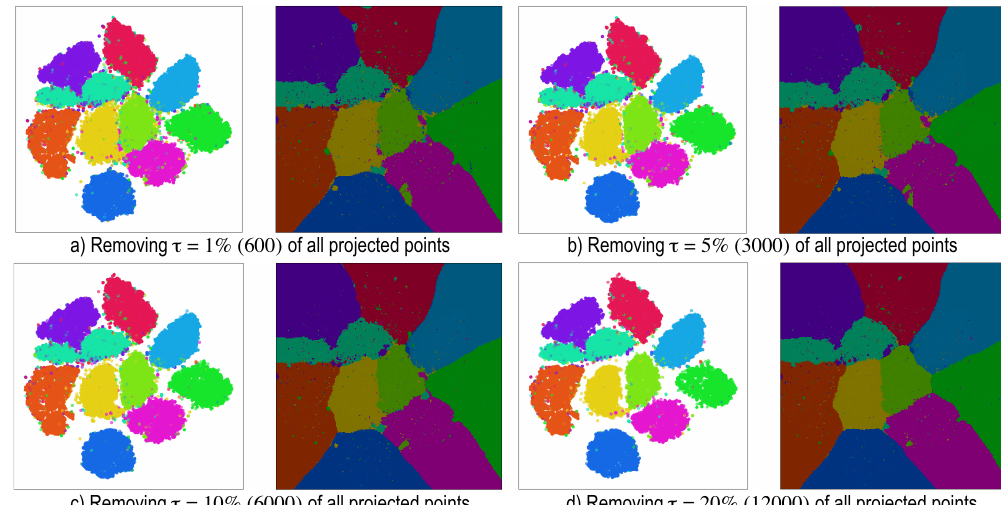
Figure 7. Removing poorly projected points with low JD k ranks to filter dense map artifacts for the MNIST dataset, projected by t-SNE, inversely projected by